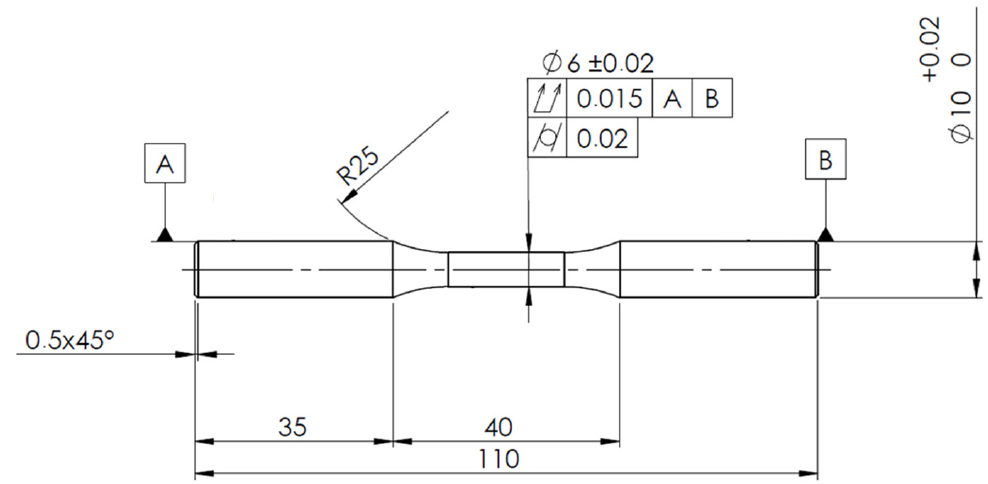
Figure 1. Sample geometry in agreement with ISO 1143 Standard (all dimensions in mm). Samples were split into three sets, depending on their position in the working chamber.